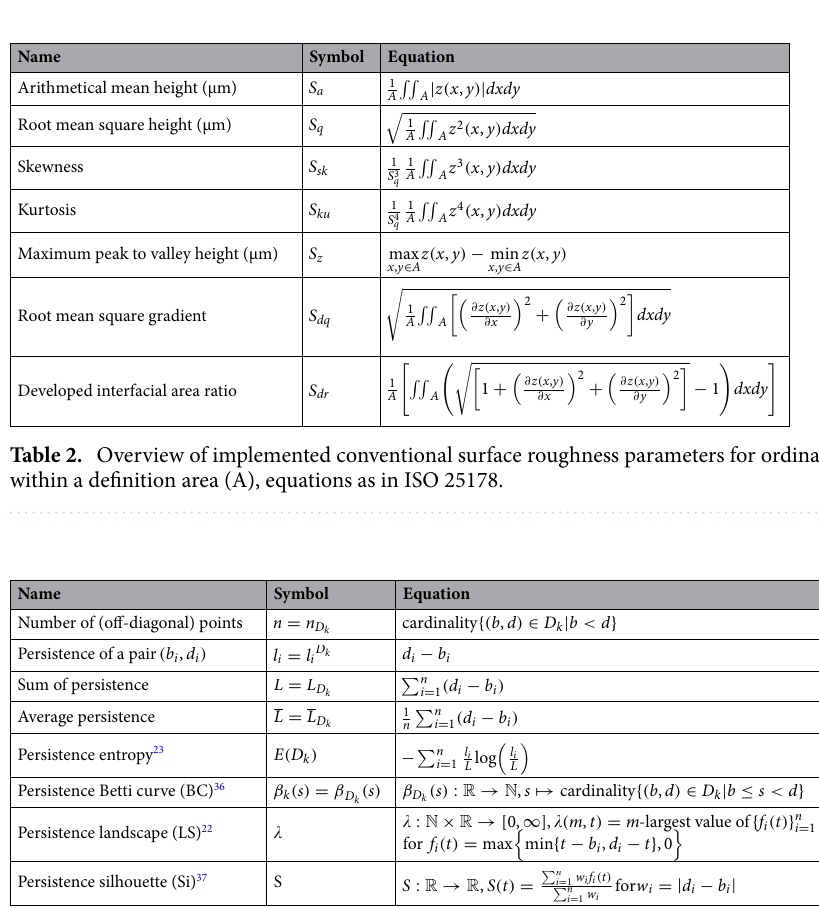
Table 3. Persistent parameters for a k-dimensional diagram D k = { ( b i , d i ) } for i = 1, ..., m . Since the persistence diagram is a multiset, the same persistence pair can occur several times in summations and sets. For simplicity sake, we often drop the index k . The death time of the infinite persistence pair in dimension 0 is changed to the maximum height value of the roughness